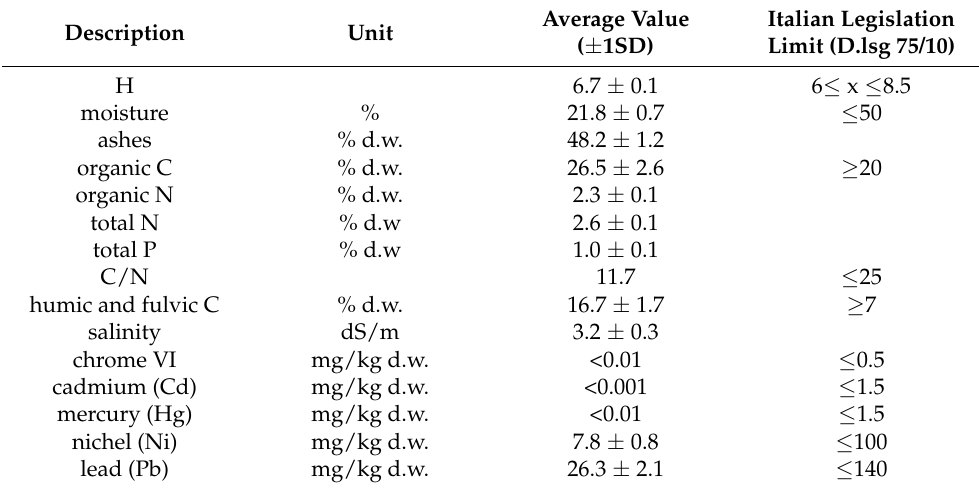
Table 1. Physical and chemical analyses of MCA compost used in this study ( ± 1 standard deviation, SD, n =